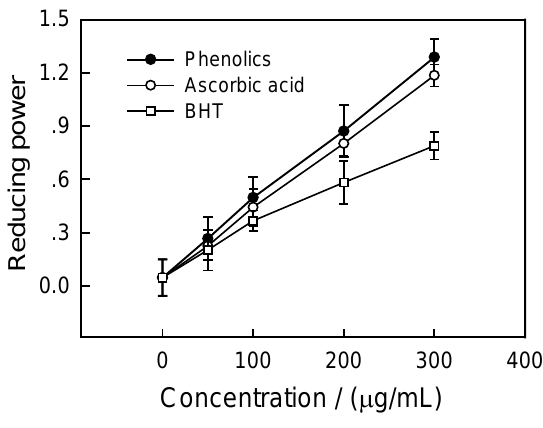
Figure 4 . Reducing power of phenolics from CWC